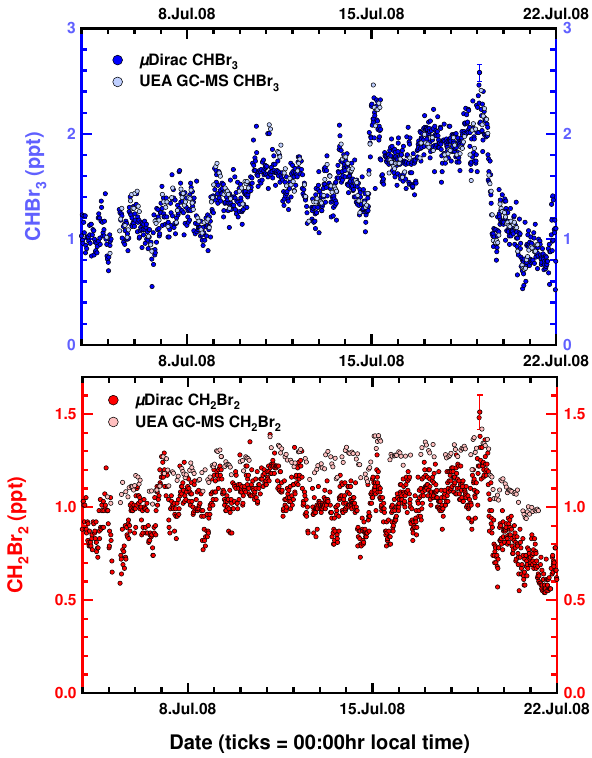
Fig. 11. CHBr 3 and CH 2 Br 2 mixing ratios (dry air mole fraction) measured at the Bukit Atur GAW station in Danum Valley, Borneo in June/July 2008. The dark symbols are measurements made by µ Dirac and the light symbols are measurements made by the UEA GC-MS. Both instruments used the same measurement tower with inlets which were 18m apart in height. Note that the CH 2 Br 2 peak in µ Dirac chromatograms is not resolved from the CHBrCl 2 peak (we report the combined peak as CH 2 Br 2 ) . The estimated